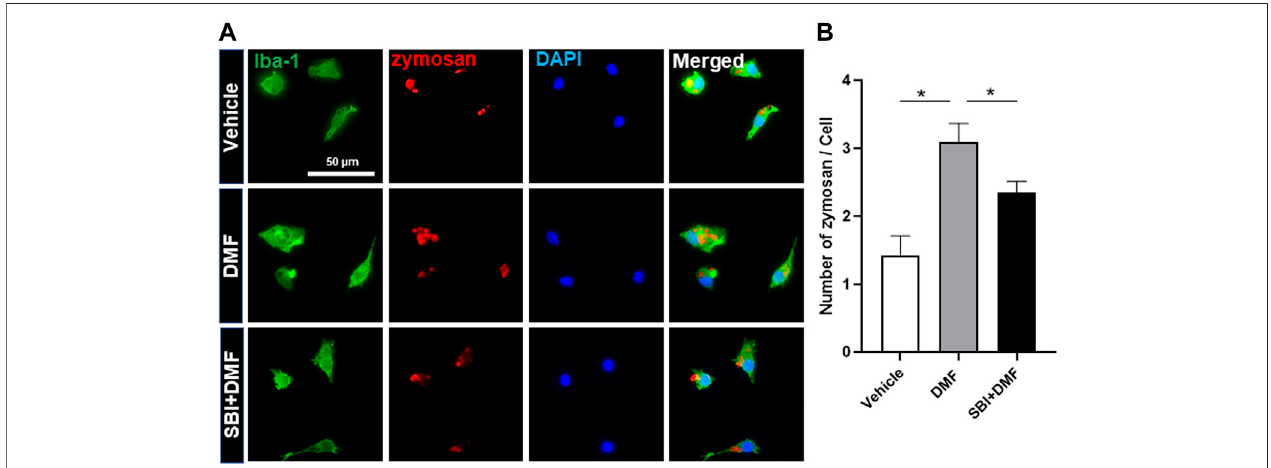
FIGURE 6 | DMF increases phagocytosis via an autophagy-dependent pathway in microglia (A, B) Primary microglia were seeded 5 × 10 4 cells/well in a 24-well plateandincubatedovernight.CellswerethenpretreatedwithSBI-0206965(5 μ M)for1 h,followedbytheadditionofDMF(10 μ M).After24 h,opsonizedzymosan-red particles were added into the cultures which were incubated for 2 h. The primary microglia were stained with the anti-Iba-1 antibody. The phagocytosed zymosan particles were counted and expressed asthe number of zymosan particles per cell. The analysis included 78 control cells, 96 cells treated with DMF, and 110 cells treated with DMF plus SBI-0206965. n (cid:2) 3 independent experiments/group. Data are presented as means ± SEM. * P < 0.05 from